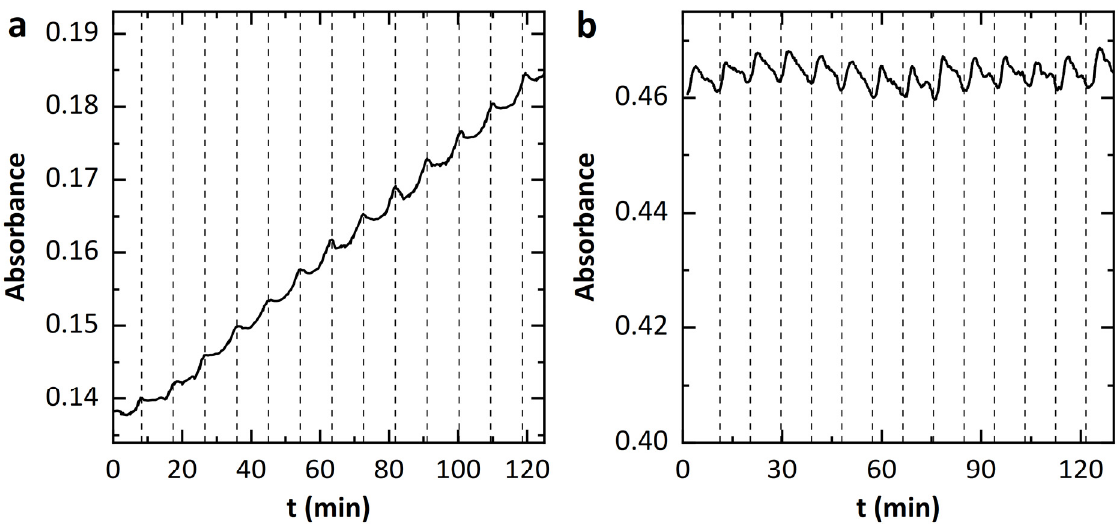
Figure 6. Influence of an alternating electric field on the absorption of TNB 2 − . ( a ) Measurement of the absorbance during the kinetic of AChE under the influence of an oscillating field with frequency sweep from 1 MHz to 80 MHz. ( b ) Measurement of absorbance for a saturated solution of the Ellman assay with the same electric field parameters.